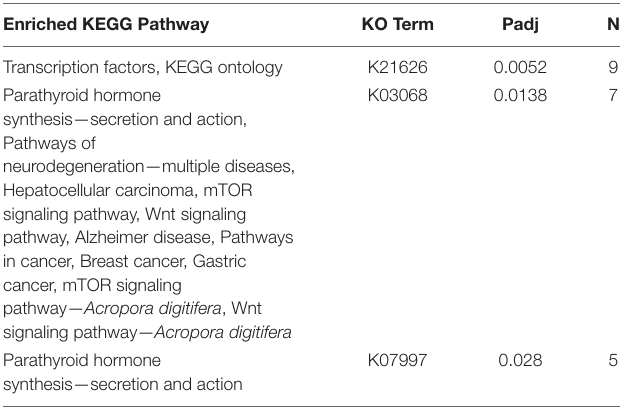
TABLE 1 | Significantly enriched KEGG Pathways associated with the O. faveolata differentially expressed gene